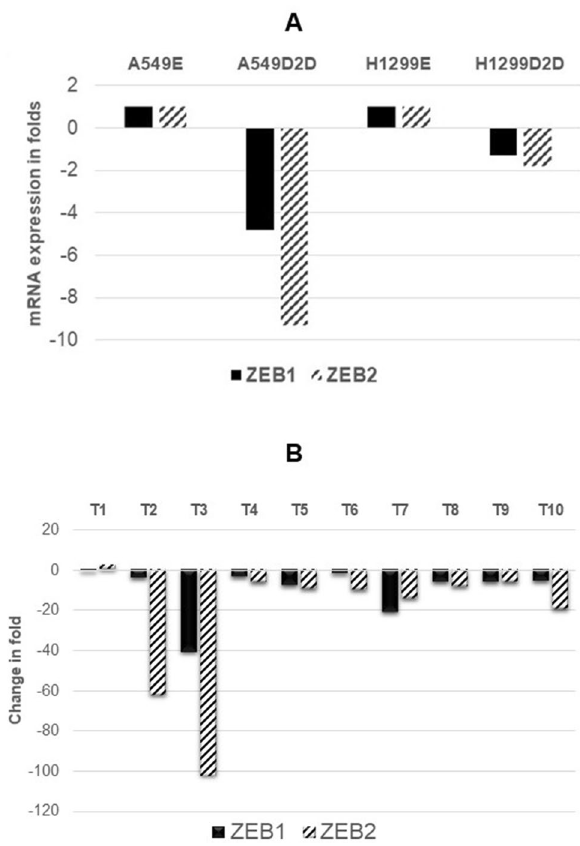
Figure 5. AmpliSeq analysis of ZEB1 and ZEB2 Gene RNA Expression. AmpliSeq analysis was used to analyze FANCD2 knockdown lung cancer cells and 10 FANCD2 foci negative tumor samples and matched non-tumor lung tissues in ZEB1, and ZEB2 expression levels. Both ZEB1 and ZEB2 are miRNA-200C downstream genes. Increased miRNA-200C expression in FANCD2 deficient samples would impact on expression of its target genes. A: FANCD2 knockdown lung cancer cells. B: Among the 10 FANCD2 foci negative tumor samples and matched non-tumor lung tissues (non-tumor control value is 1), 100% showed downregulation of ZEB1 and 90% for ZEB2 compared to matched